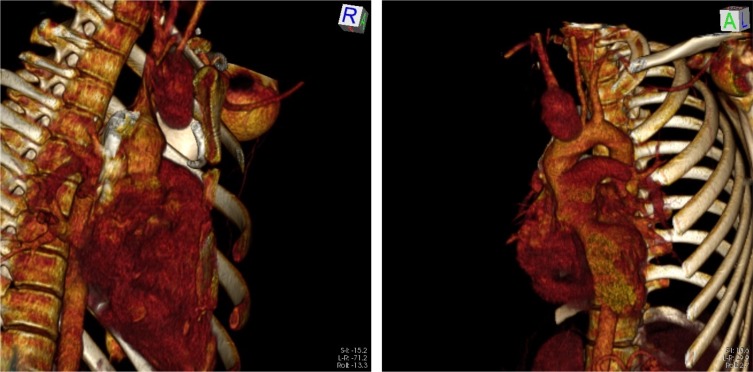
Reconstructed angiotomography images showing an aneurysm of the brachiocephalic trunk.